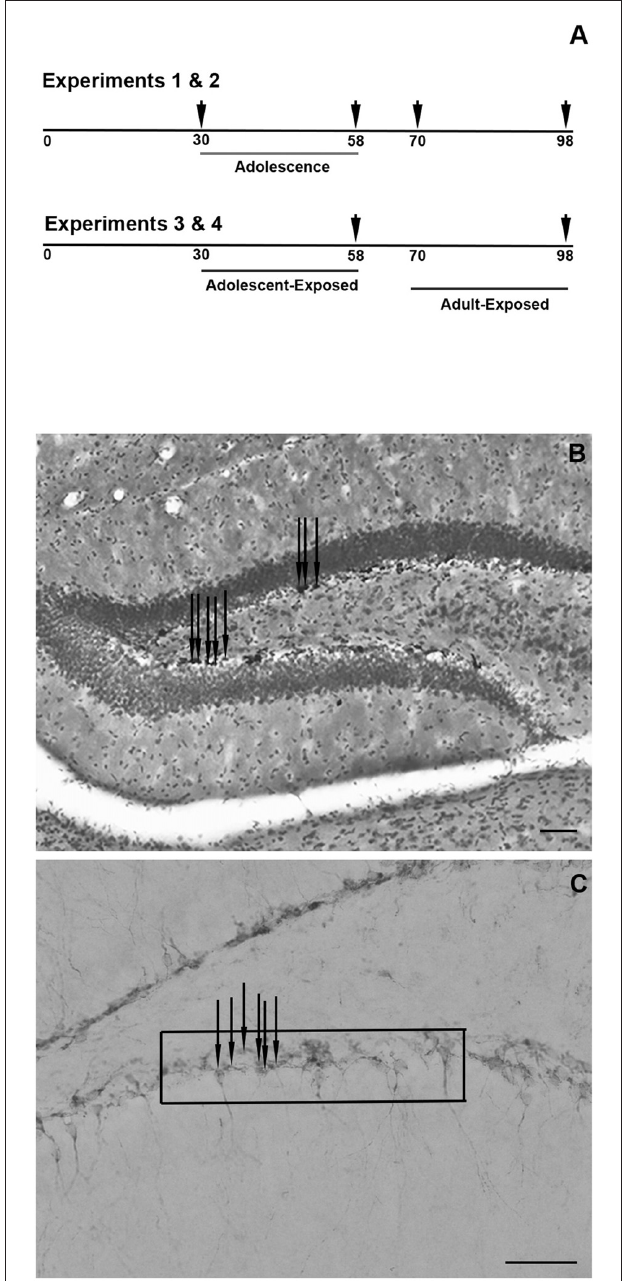
FIGURE 1 | Schematic timeline of the experiments, with arrowheads indicating the times of tissue collections (A) . Representative photomicrograph of the counter-stained dentate gyrus and Ki-67-positive cells (B) and representative photomicrograph of the doublecortin (DCX)-positive cells in the dentate gyrus and the approximate placement of the grid used to quantify the cells (C) Scale bars in panels (B,C) = 50 µ m. Note that the arrows in panels (B,C) are indicating a few examples of Ki-67- and DCX-positive cells, respectively.